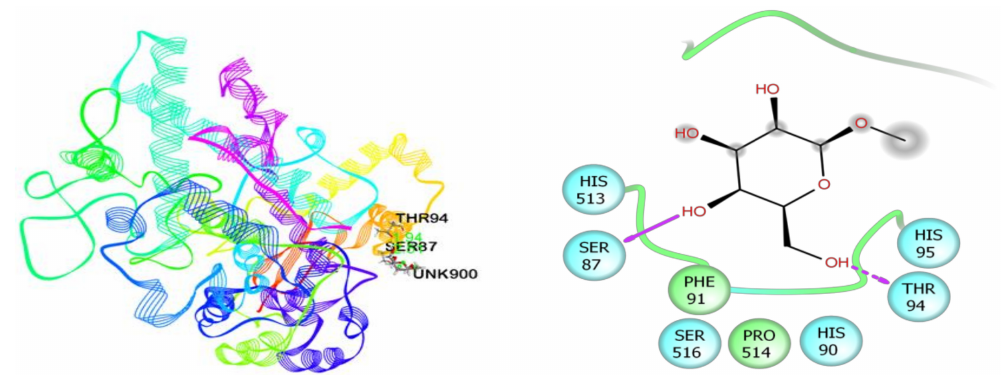
Figure 9. Best ranked poses and 2D interactions of β -D-Glucopyranoside, methyl with COX-1 enzyme (pdb: 2OYE) for anti-inflammatory